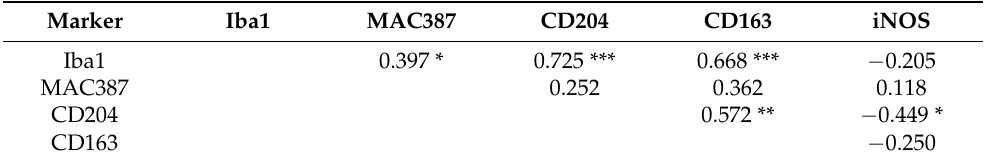
Table 3. Spearman correlation test.